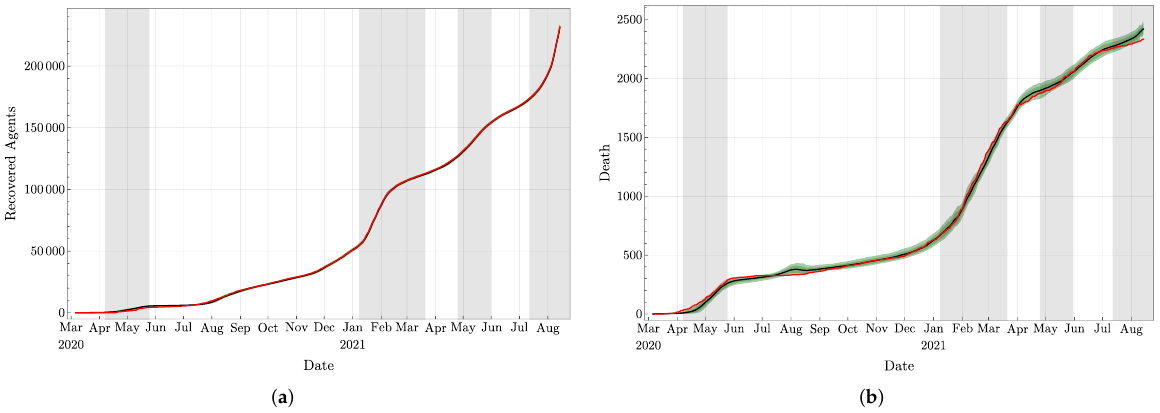
Figure 7. Observation values (in red) and analyzed values with mean value (in black) and 68%, resp. 90%, confidence interval: ( a ) compartment R of recovered after treatment and ( b ) compartment D of